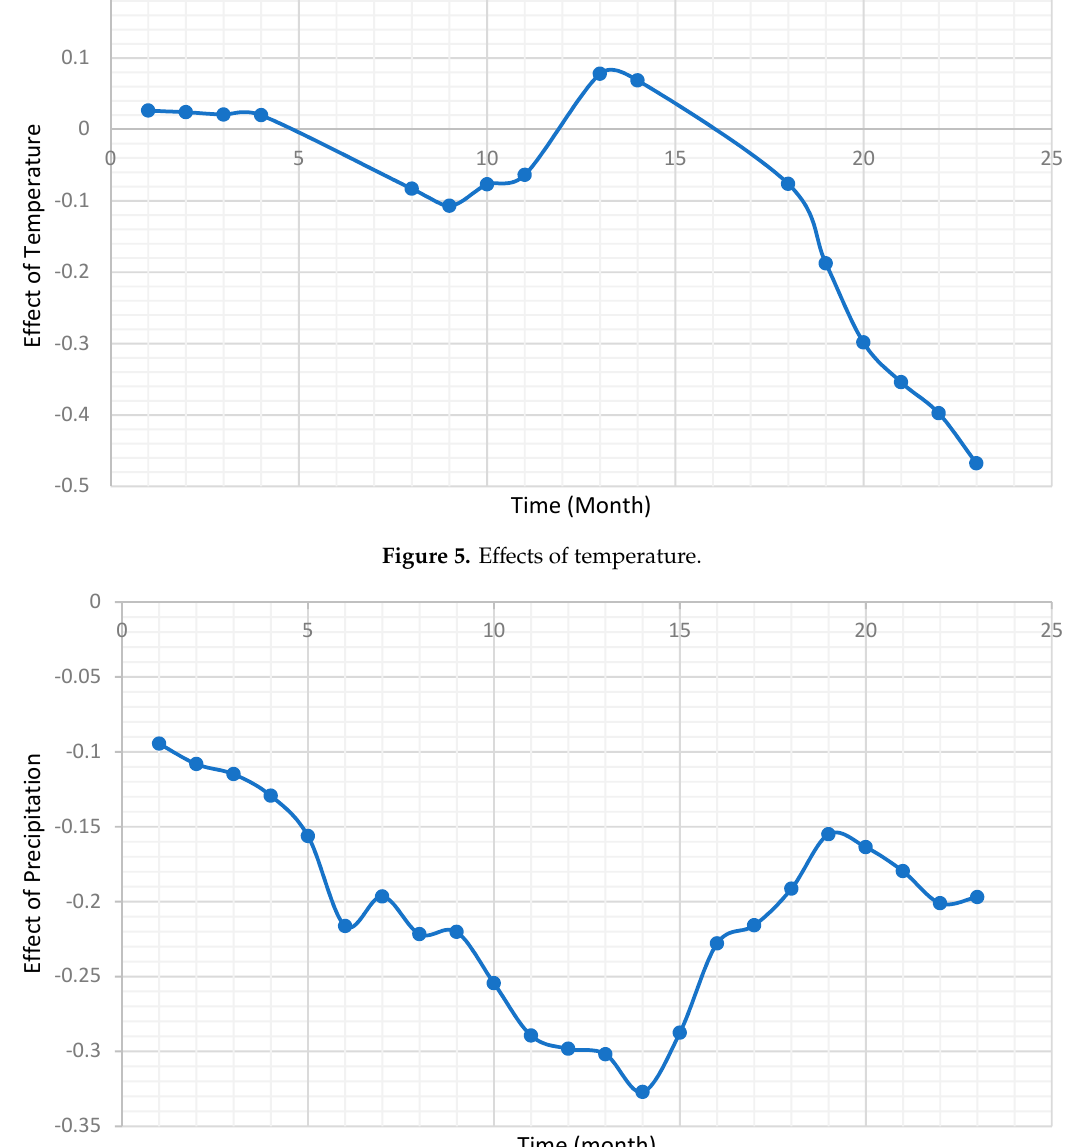
Figure 6. E ff ects of Figure 6. Effects of precipitation.